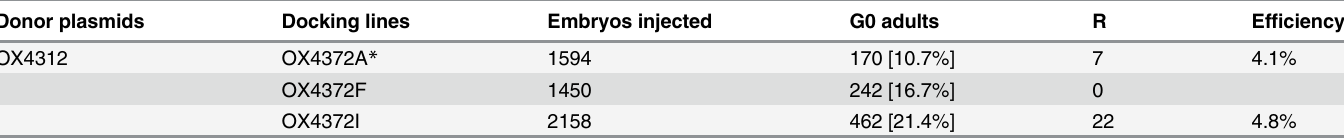
Table 2. Summary of Ae . aegypti OX4312 injections for Φ